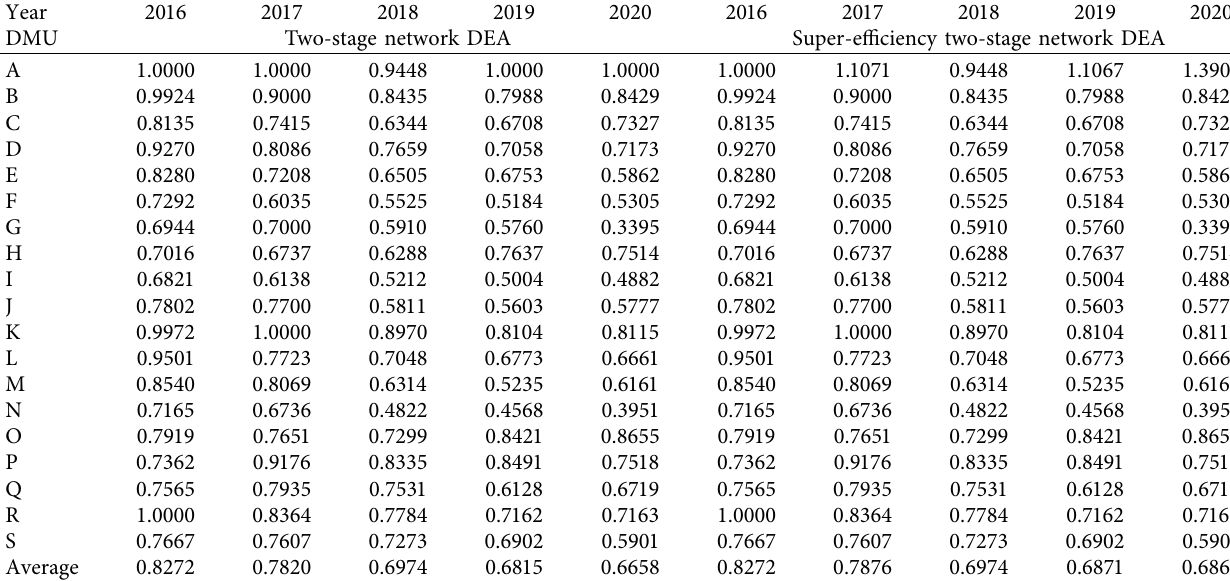
Table 2: Measurement results of various banks in stage